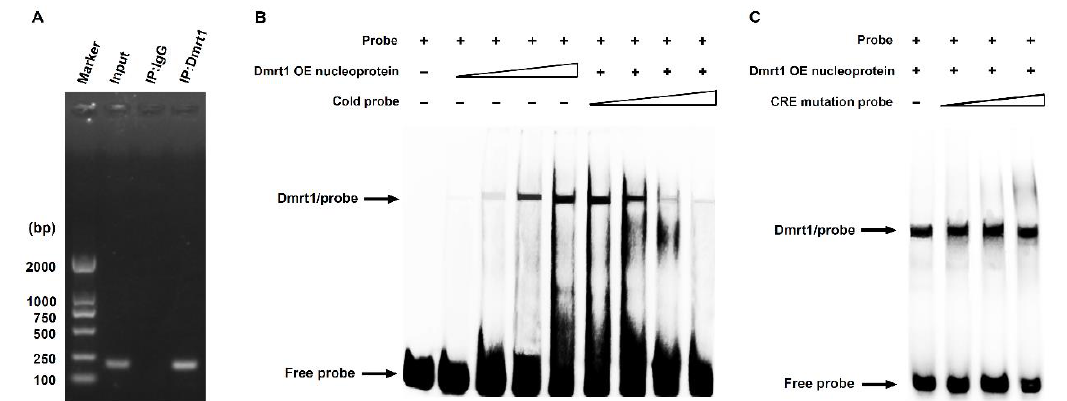
Figure 5. Direct binding of Dmrt1 to specific CRE within the Nile tilapia Sox30 promoter. ( A ) Chromatin immunoprecipitation (ChIP) assays of the binding of Dmrt1 to putative CRE in the Sox30 promoter in the testis of Nile tilapia at 90 dah. A primer pair covering the Sox30 promoter region containing putative CRE for Dmrt1 was used for PCR examination in the products precipitated from the Nile tilapia testes with an anti-Dmrt1 antibody. ( B ) Electrophoretic mobility shift assay (EMSA) analysis of the binding of Dmrt1 to specific CRE in the Nile tilapia Sox30 promoter. Specific probe against putative CRE for Dmrt1 was designed. The unlabeled intact probes could compete for the binding of Dmrt1 to the labeled intact probes in a dose-dependent manner. ( C ) The unlabeled probe with a mutation of putative CRE for Dmrt1 could not suppress the binding of Dmrt1 to the labeled intact probe.